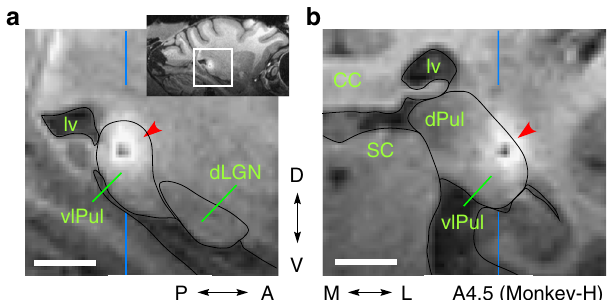
Fig. 4 The diffusion extent of injected muscimol. Injection of mixture of muscimol and Gd 3 + (see Methods and i in Supplementary Figure 2G) resulted in the localized signal in the MRI (red arrowhead). It seems as if there was a black hole, but it was not a hole (Supplementary Figure 4). a The parasagittal slice: vertical blue lines indicate the anteroposterior position of b . Note that the strong signal did not extend to the dLGN. b The coronal slice: vertical blue lines indicate the mediolateral position of a . Scale bar: 5